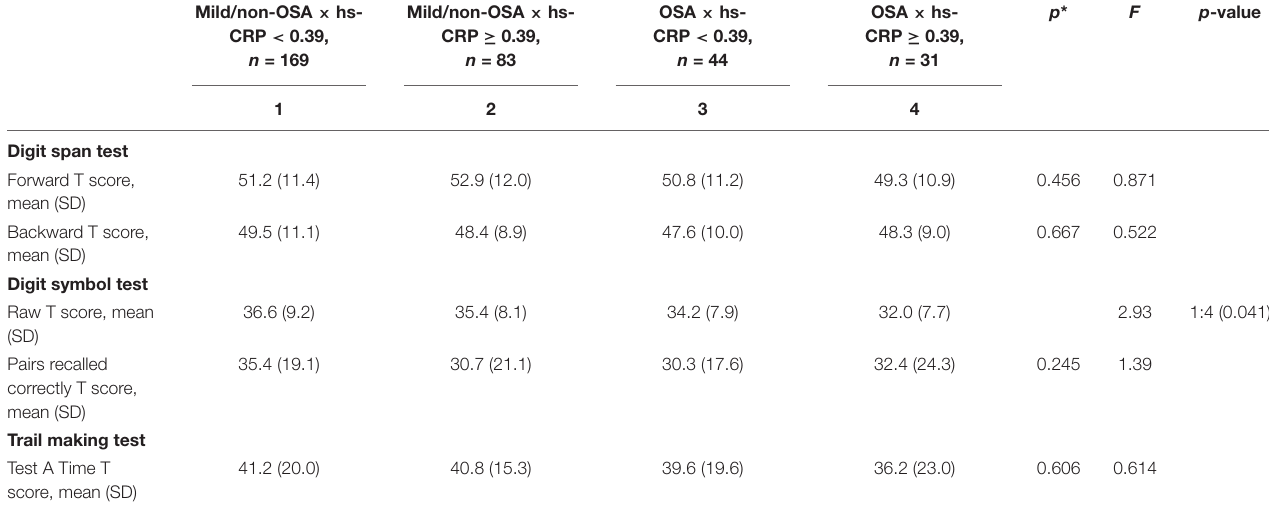
TABLE 3 | Means differences of the cognitive functioning in the four groups stratified according to the presence of obstructive sleep apnoea and the level of hs-CRP (high vs. low). Mild/non-OSA × hs- CRP <